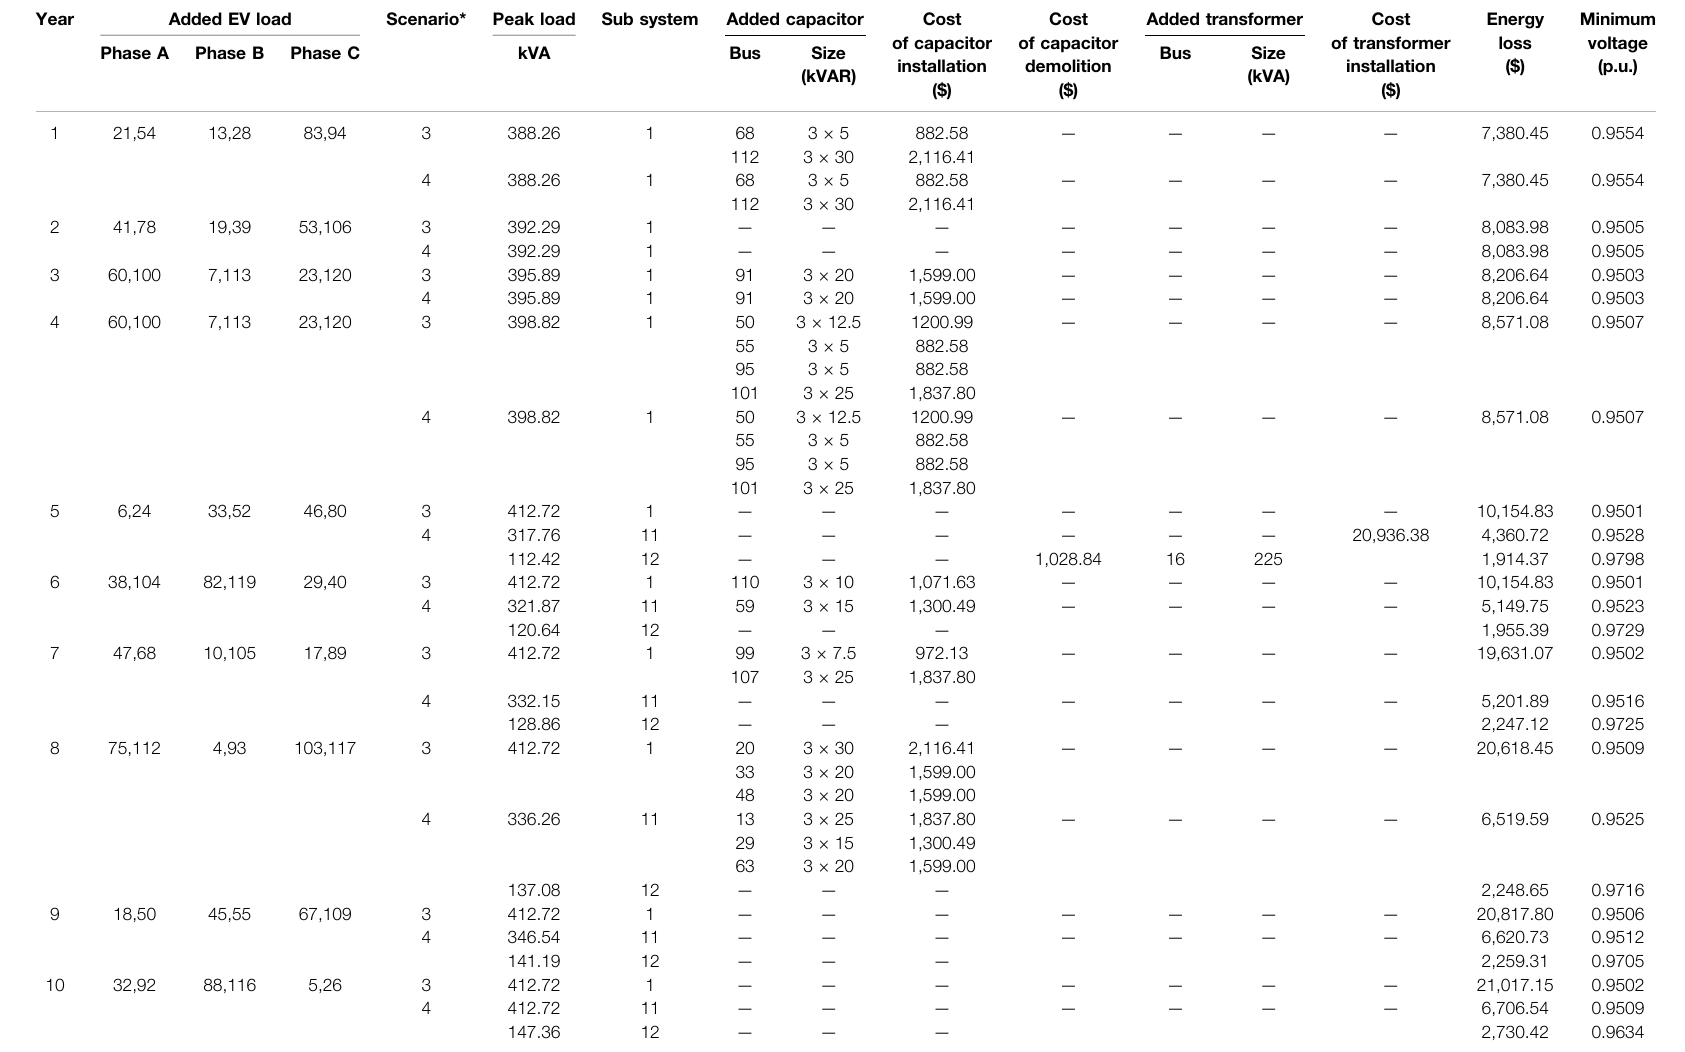
TABLE 4 | Optimal planning schedule for scenarios 3 and